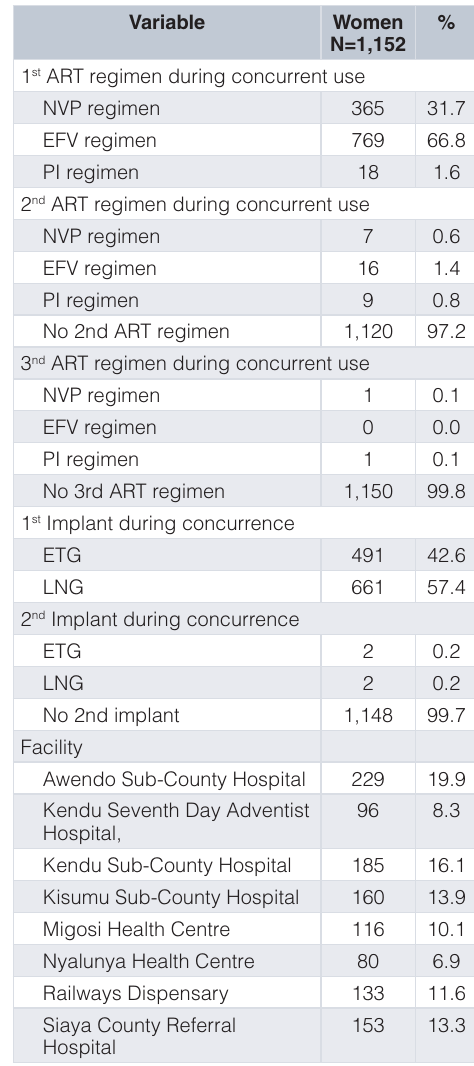
Table 1. Concurrent use of implants and antiretrovirals by